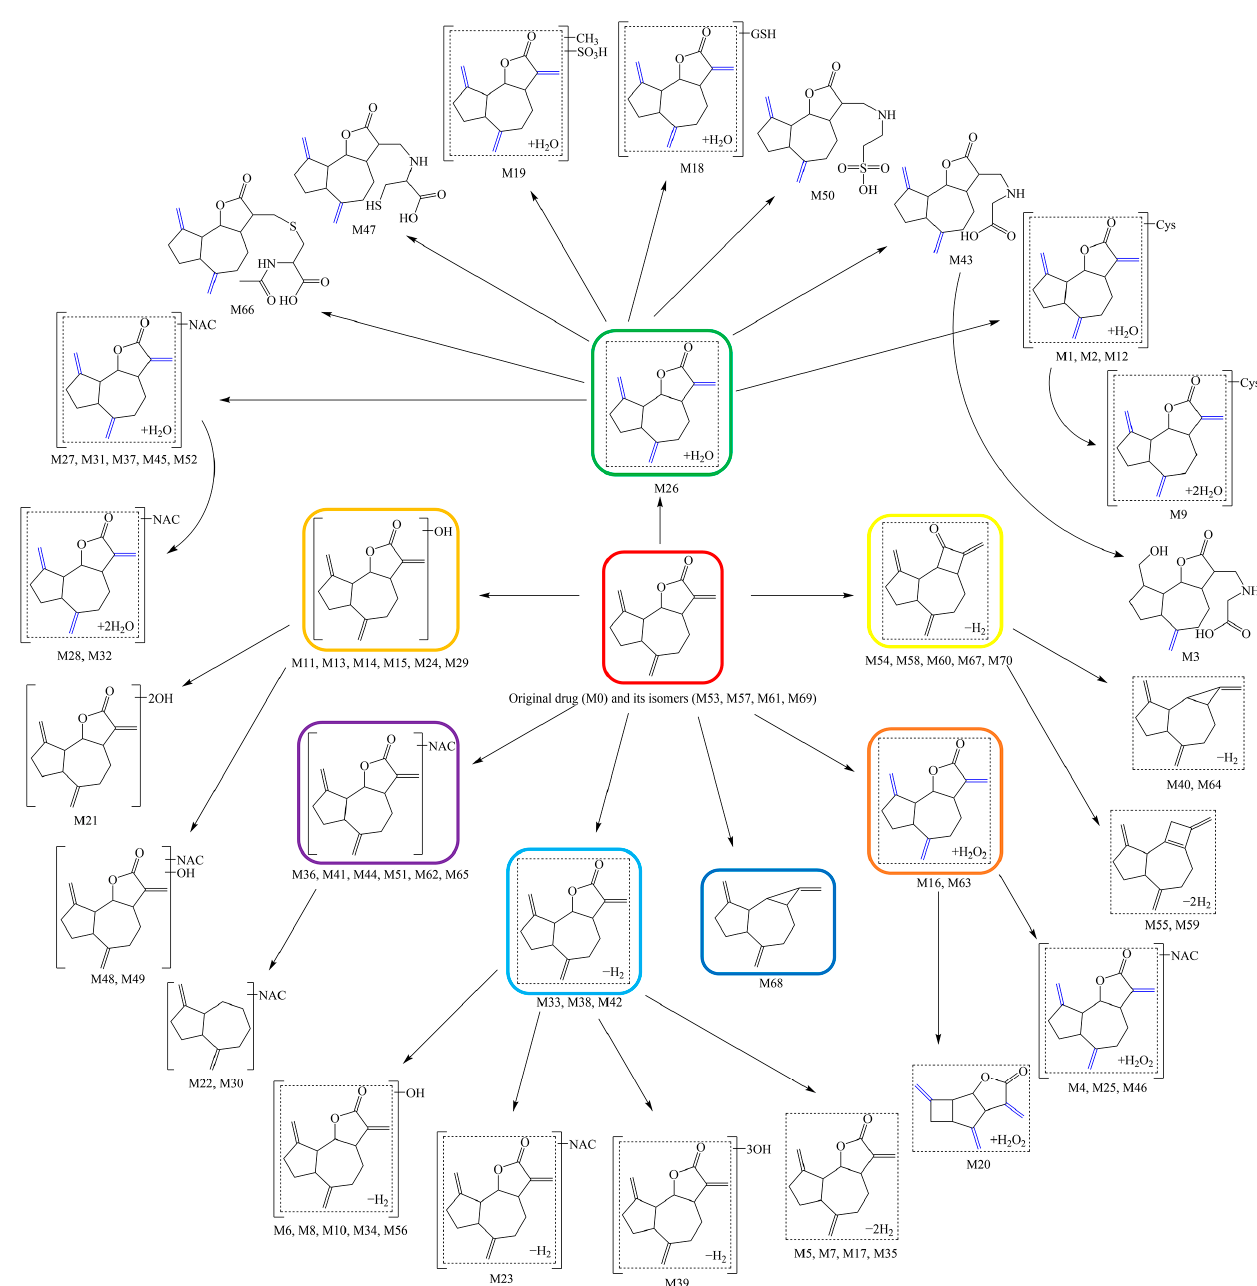
Figure 7. Mapping of the metabolic network for DL in rats.